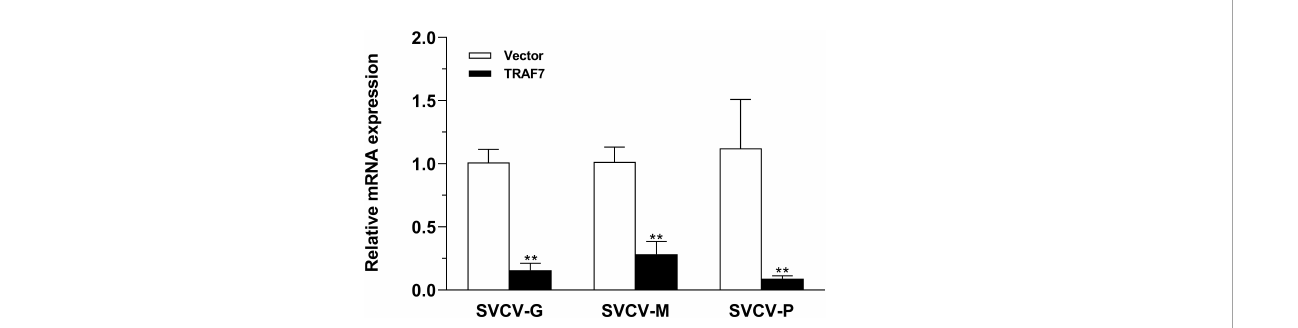
FIGURE 8 Antiviral assay of Lc -TRAF7 in fi sh cells. EPC cells in 6-well plates (2 × 10 6 cells/well) were transfected with 2.5 m g of pcDNA3.1-TRAF7 or pcDNA3.1 empty vector (control). At 24 hpt, the cells were infected with SVCV at an MOI of 1, the cells were then collected at 24 h post-infection for total RNA extraction, and the mRNA expression levels of SVCV-G , SVCV-M , and SVCV-P were detected by qRT-PCR analysis, with normalizing to the expression of EPC b -actin using the 2 – DD Ct method. All data are obtained from three individual experiments, with bars representing the SE. ** P <